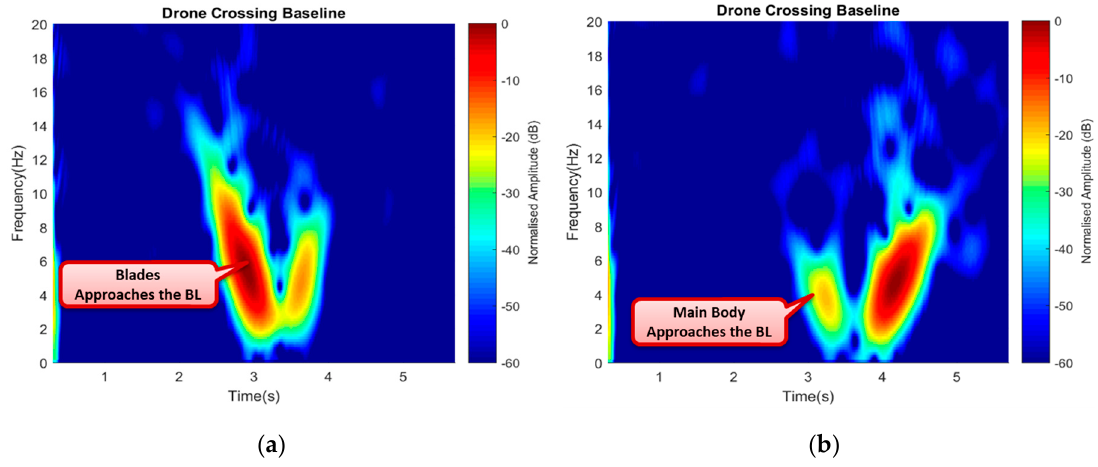
Figure 20. Drone crossing the baseline while moving vertically ( a ) upward and ( b )